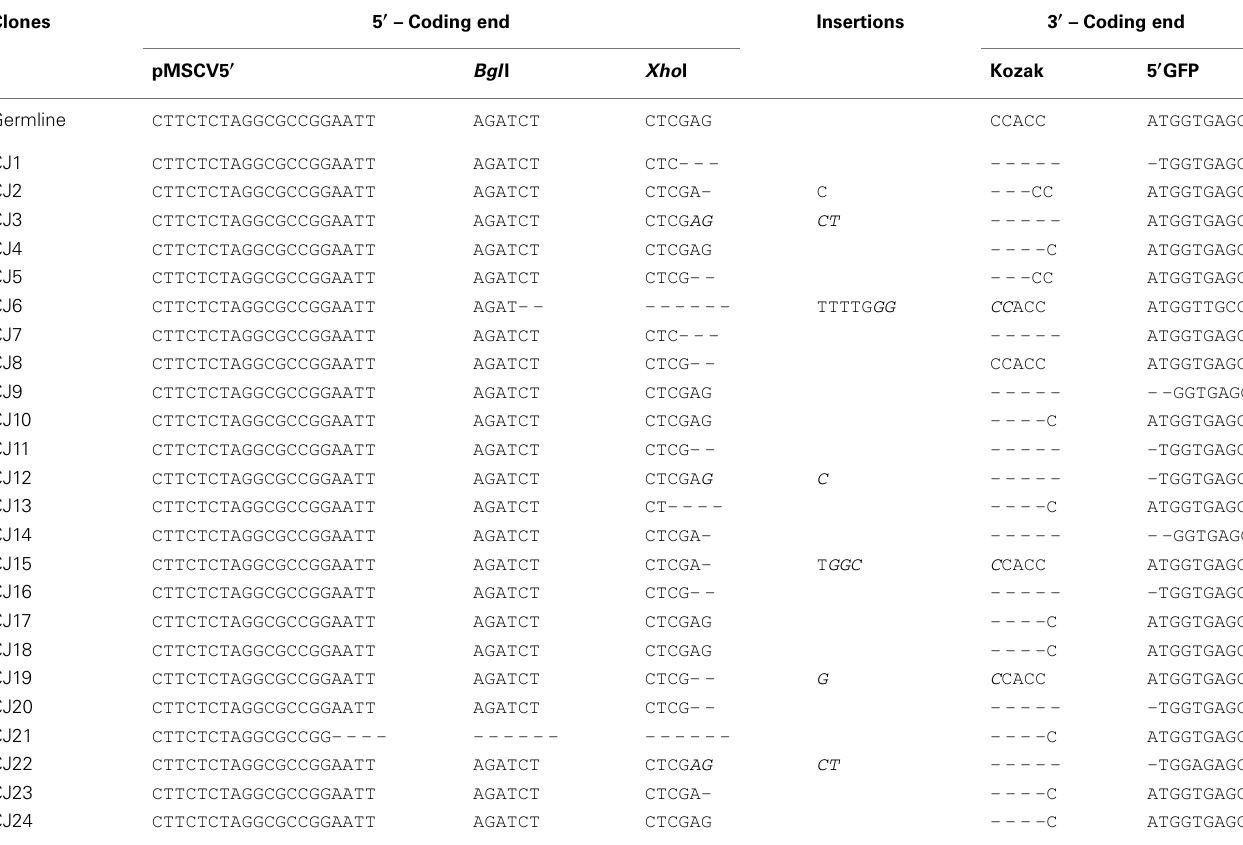
Table 3 | Sequences of rearranged GFPi-mRFP Con12/Con23 coding joints.